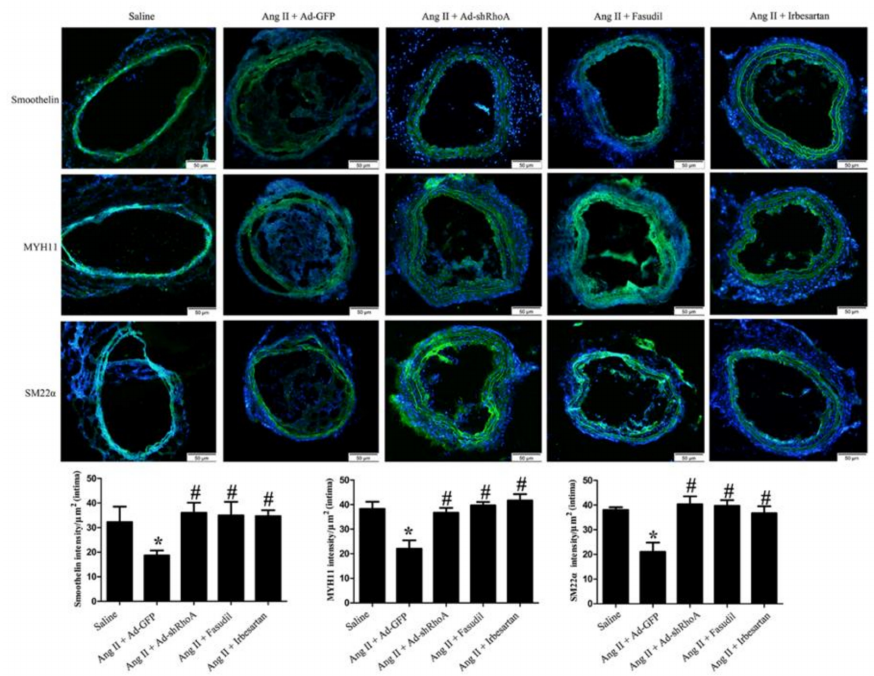
Figure 10. Immunofluorescence staining of MYH11, SM22 α , and smoothelin (green). Nuclei were stained with DAPI (blue). Mice were treated the same way as in tablee 7. Histograms show the fluorescence intensity of the staining in the intima. * p < 0.05 vs. the saline-infused group; # p < 0.05 vs. the model group (Ang II infusion + Ad-GFP virus) ( n = 10). The scar bar is 50 µ